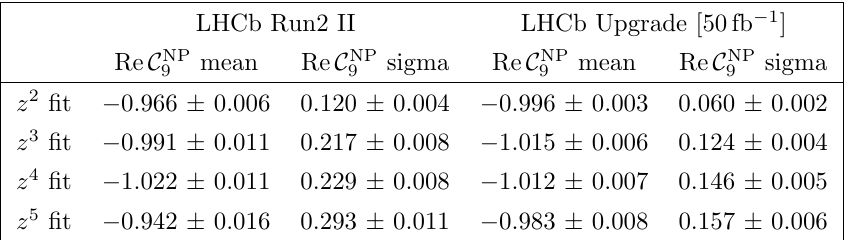
Table 2 . Expected central value and uncertainties for the C NP and z 5 (cid:12)ts for the BMP scenario with Re C NP